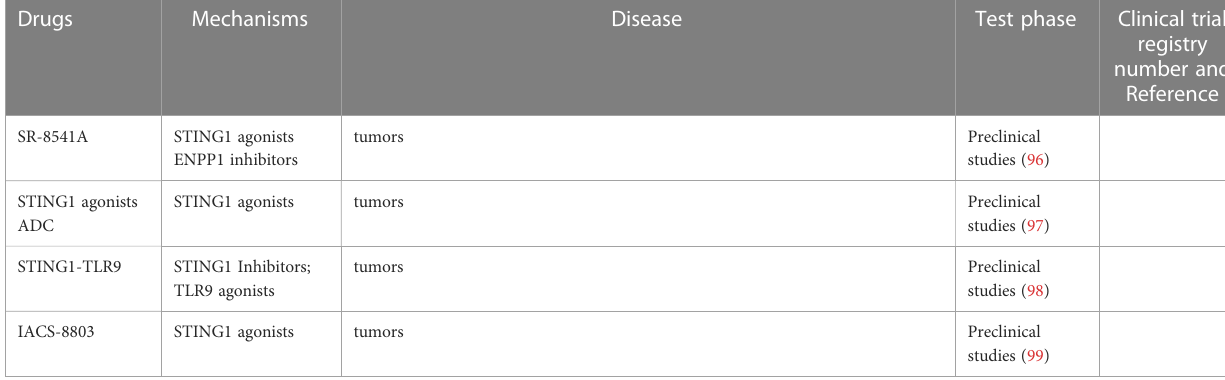
Figure 2 for a summary of the mechanisms of cGAS-STING activation by radiation